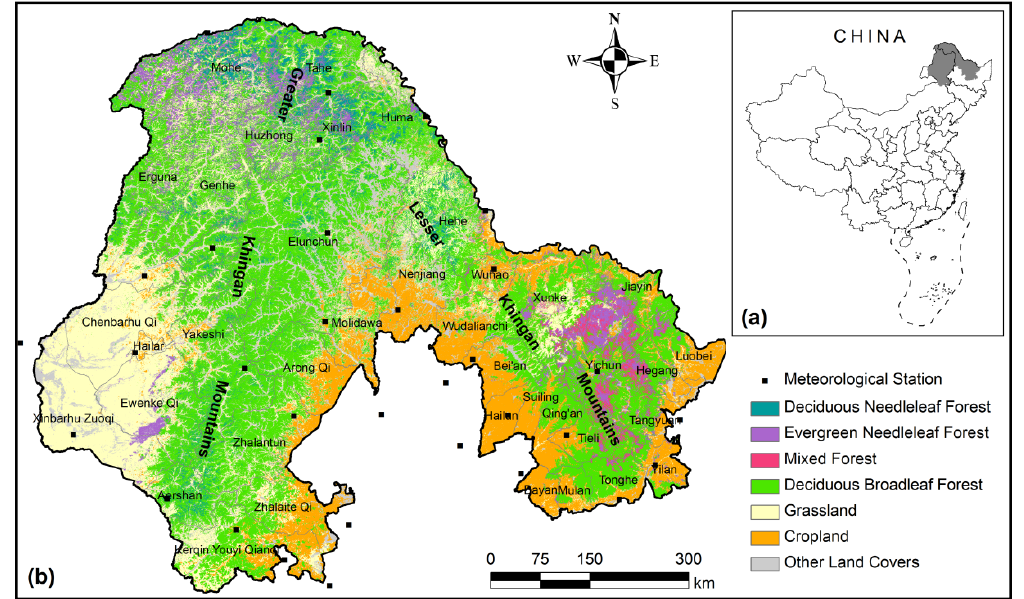
Figure 1. ( a ) The location of the Khingan Mountain region in China. ( b ) Land cover in the Khingan Mountains